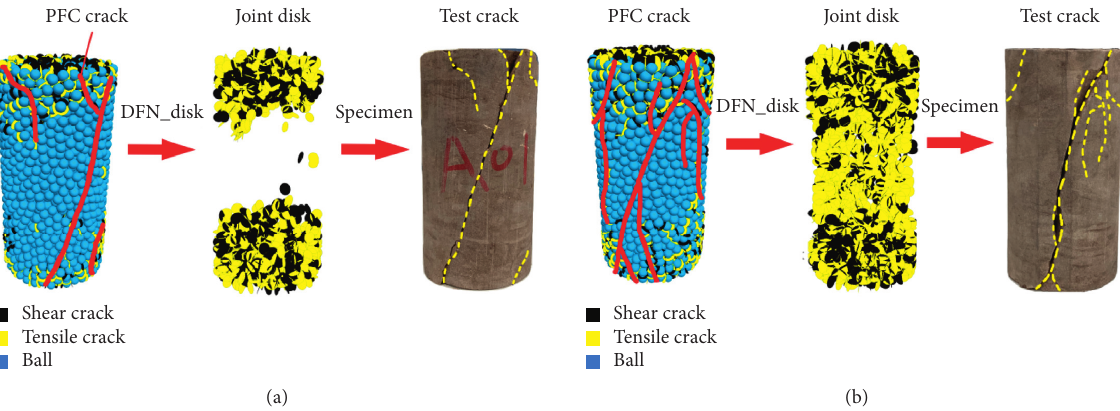
Figure 10: Numerical triaxial failure joints (cracks) of mudstone under different confining pressures. (a) Confining pressure of 2MPa. (b) Confining pressure of 8MPa.